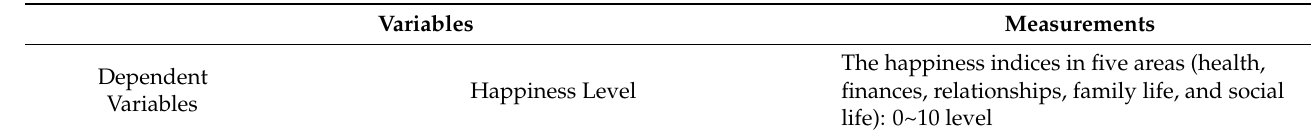
Table 1. Variables and